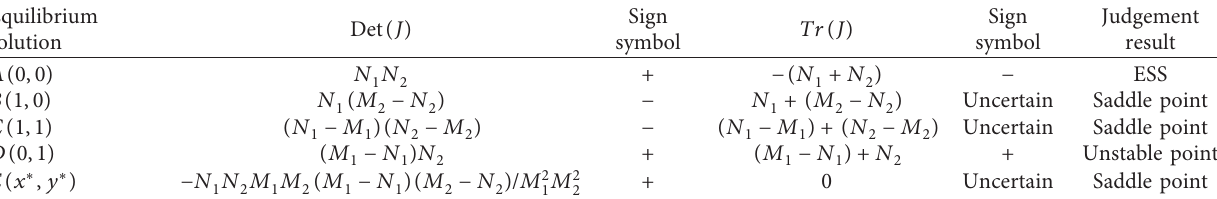
> N and M < N . 1 1 2 2